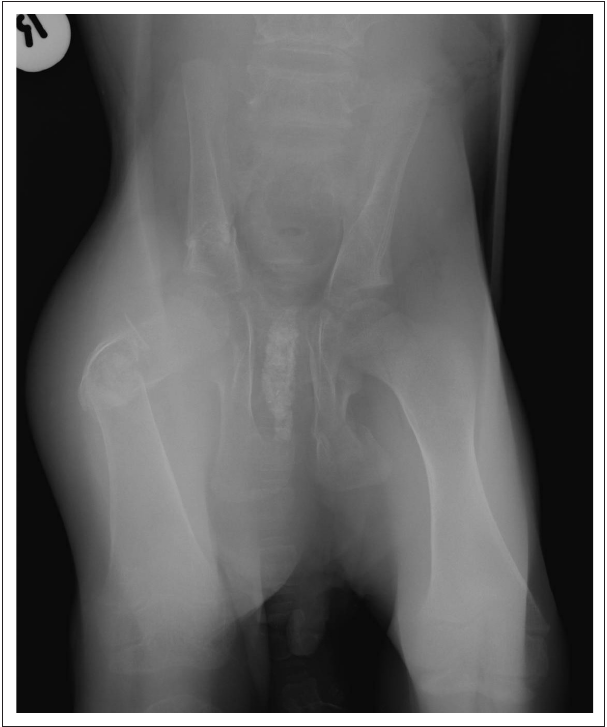
FIGURE 2: Ventro-dorsal view of the pelvis of the male cub on initial examination.